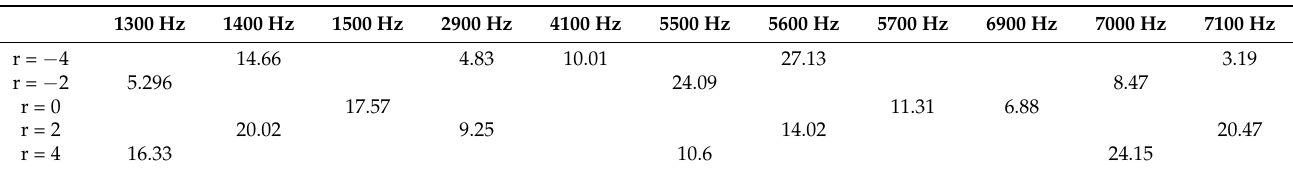
Table A1. Frequency, order and amplitude of electromagnetic force wave under normal operat- ing